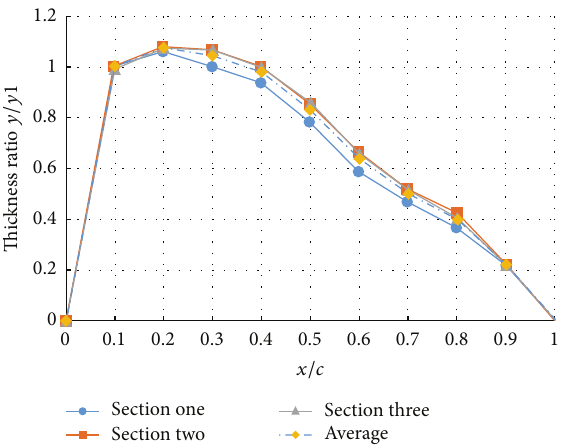
Figure 7: Three thickness ratios 𝑦/𝑦1 of tiger